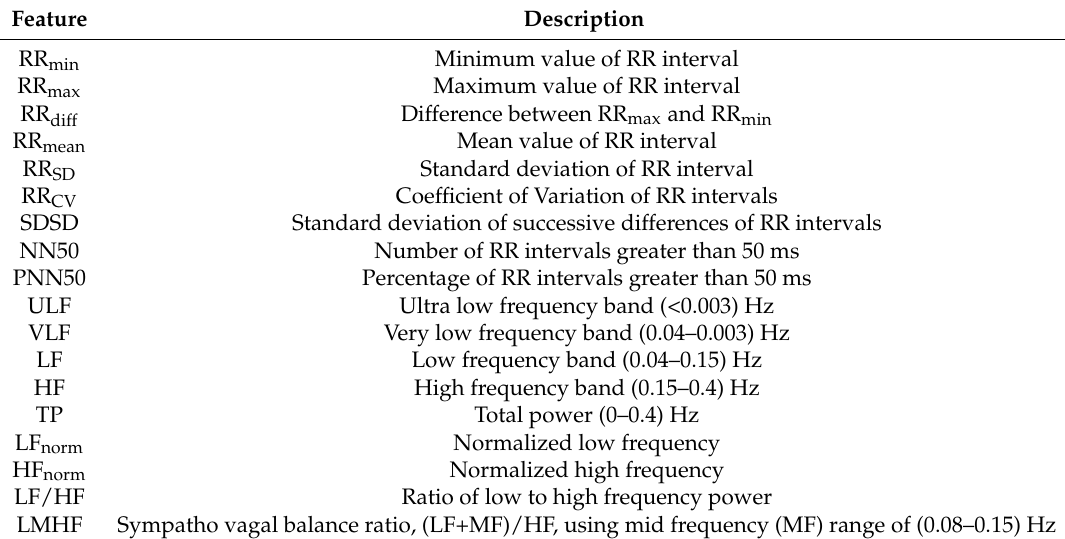
Table 1. Time and frequency domain ECG